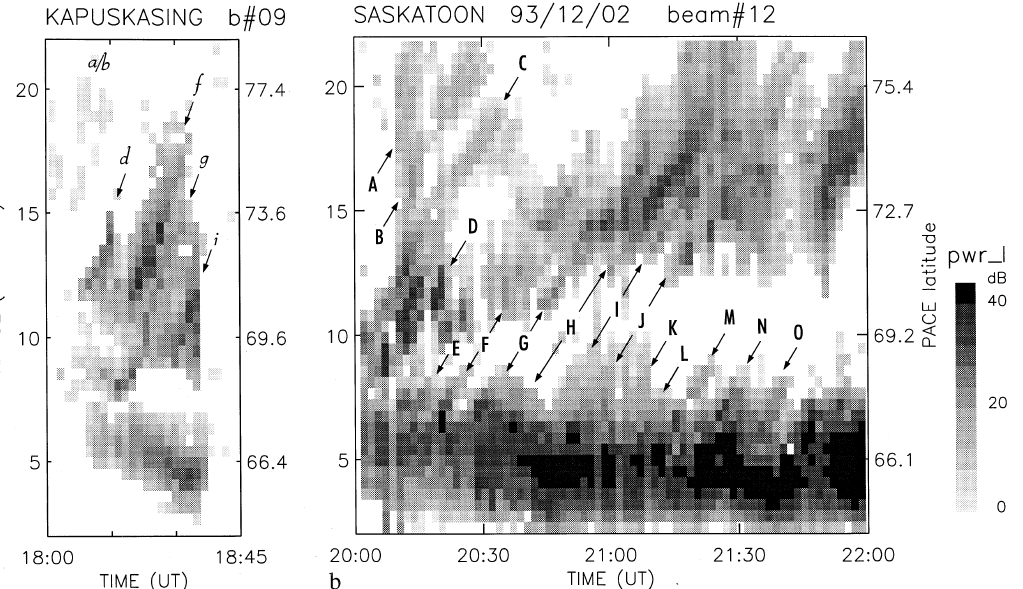
Fig. 10a, b. SuperDARN RTI plots for a Kapuskasing and b Saskatoon radars before and after 2000 UT, respectively. The E-region backscatter bands and corresponding F-region patches are